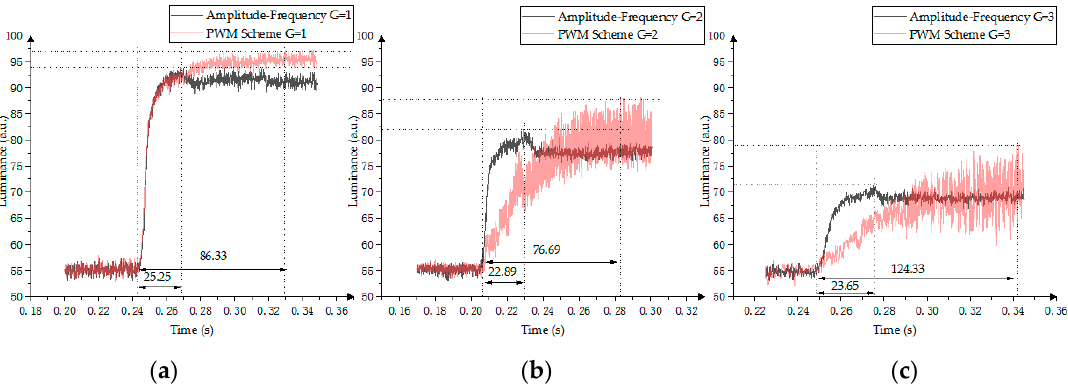
Figure 15. Response time comparison between the PWM scheme and the amplitude–frequency mixed modulation. ( a ) First gray scale; ( b ) Second gray scale; ( c ) Third gray scale.